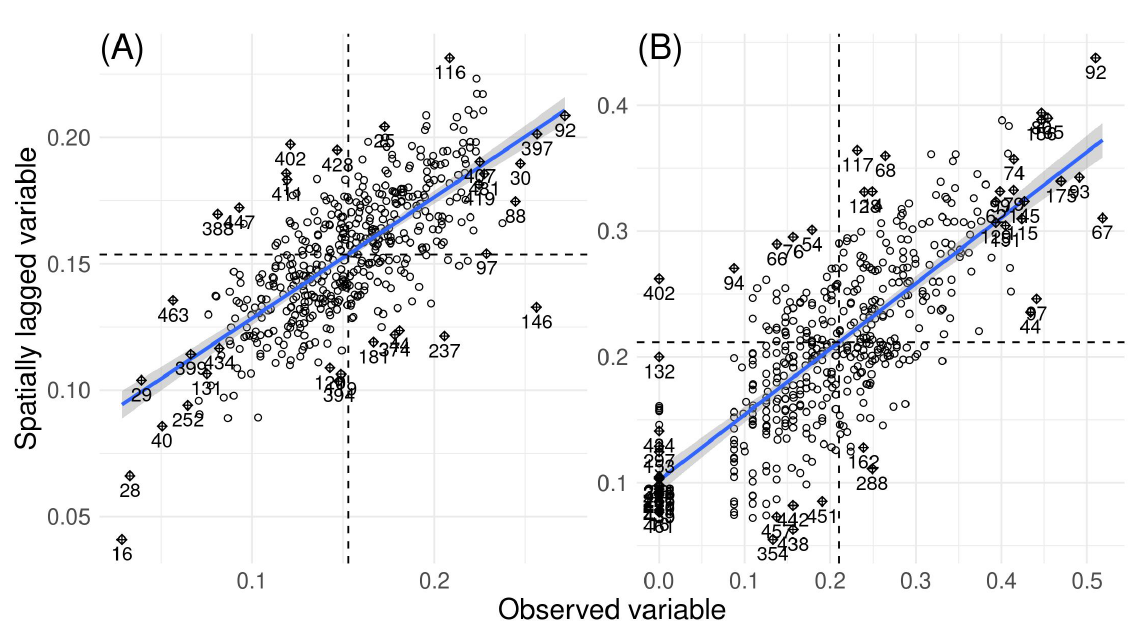
Figure S5 – Moran scatterplots of the transformed versions of the analyzed variables. (A) Average forest loss per unit area per year of the period 2001-2018. (B) average number of fire points per km 2 per year in the period 2001-2018 using MODIS dataset.